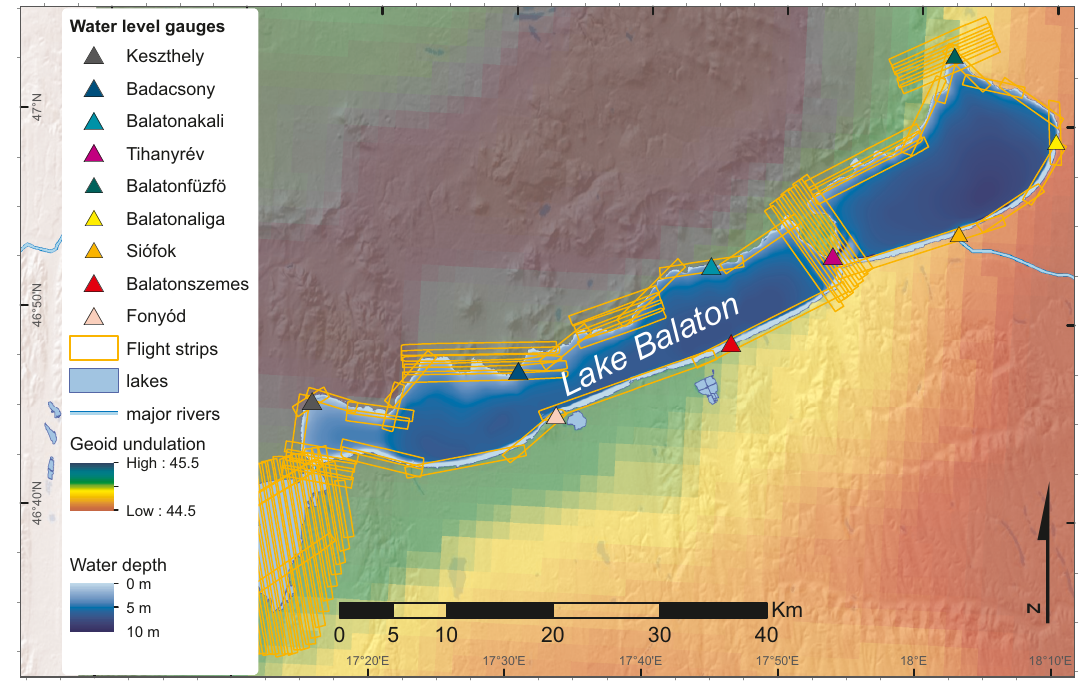
Figure 1. Map of the study area, including quasi-geoid heights, bathymetry of Lake Balaton and flight pattern. Terrain topography is repre- sented by relief shading. Note quasi-geoid high NW of the